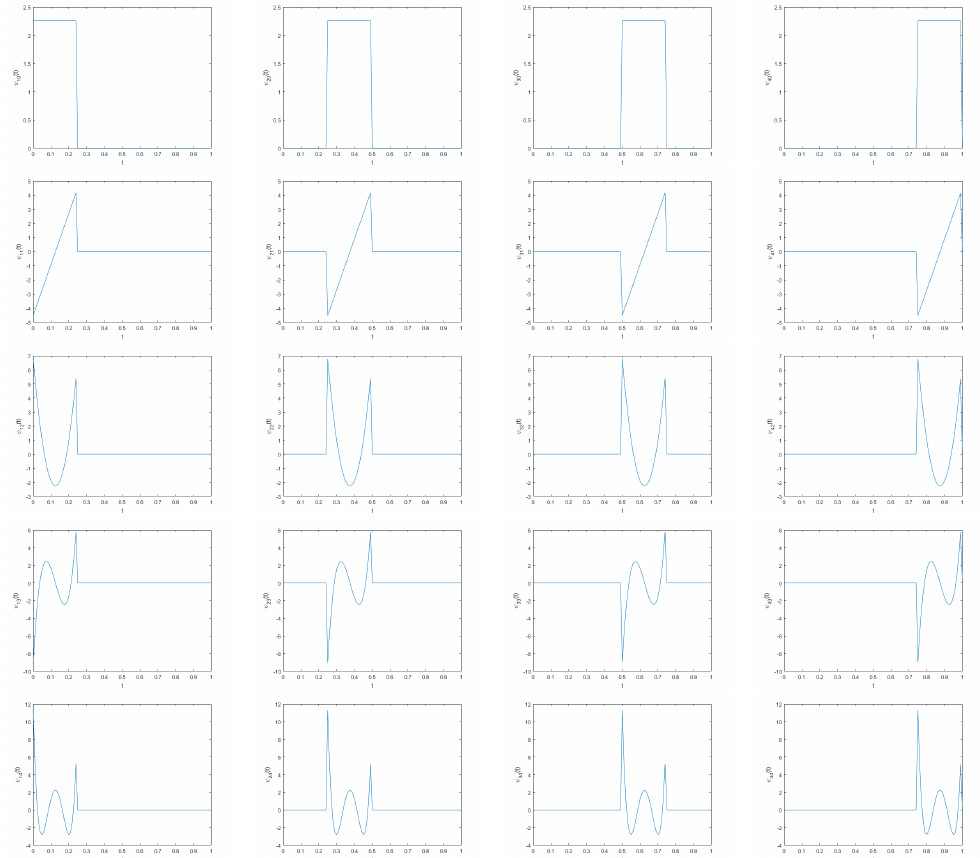
Figure 1. The second Chebyshev wavelet charts for k = 3 and M =